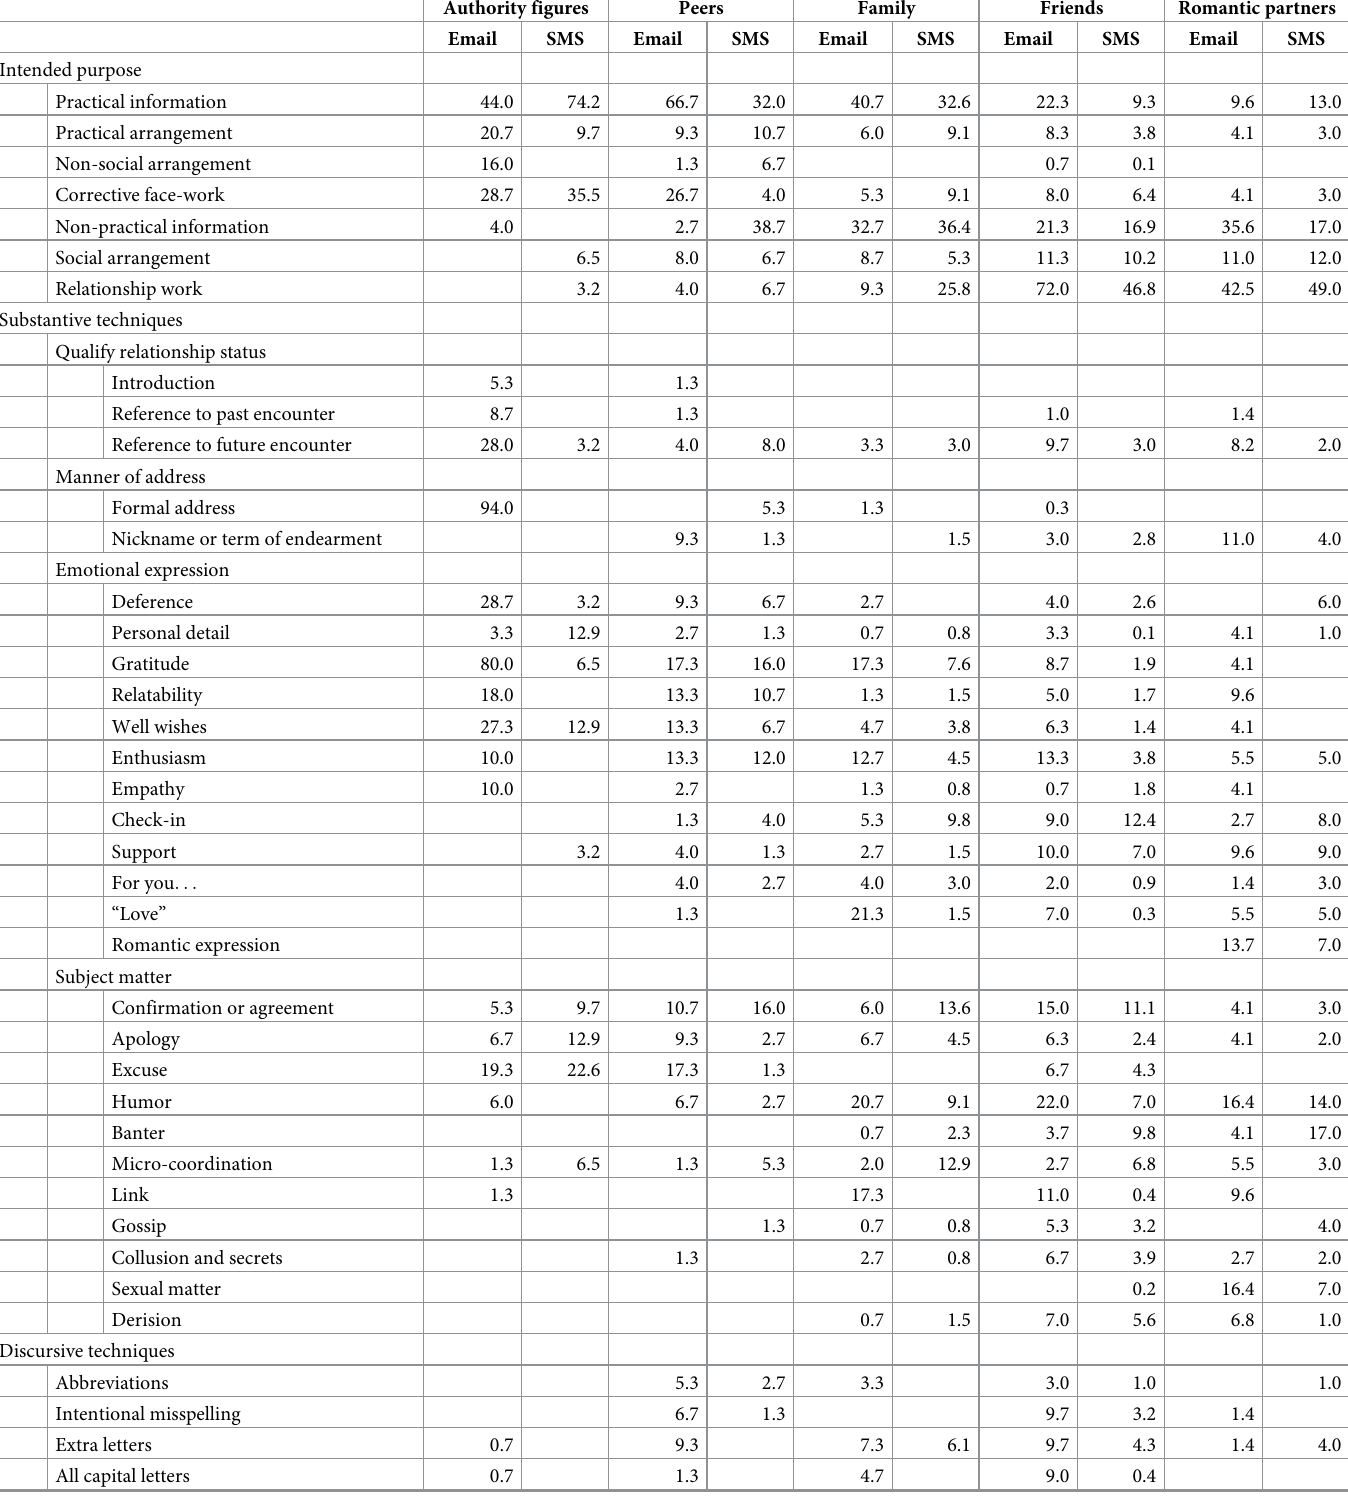
Table 5. The distribution of codes by medium and relationship